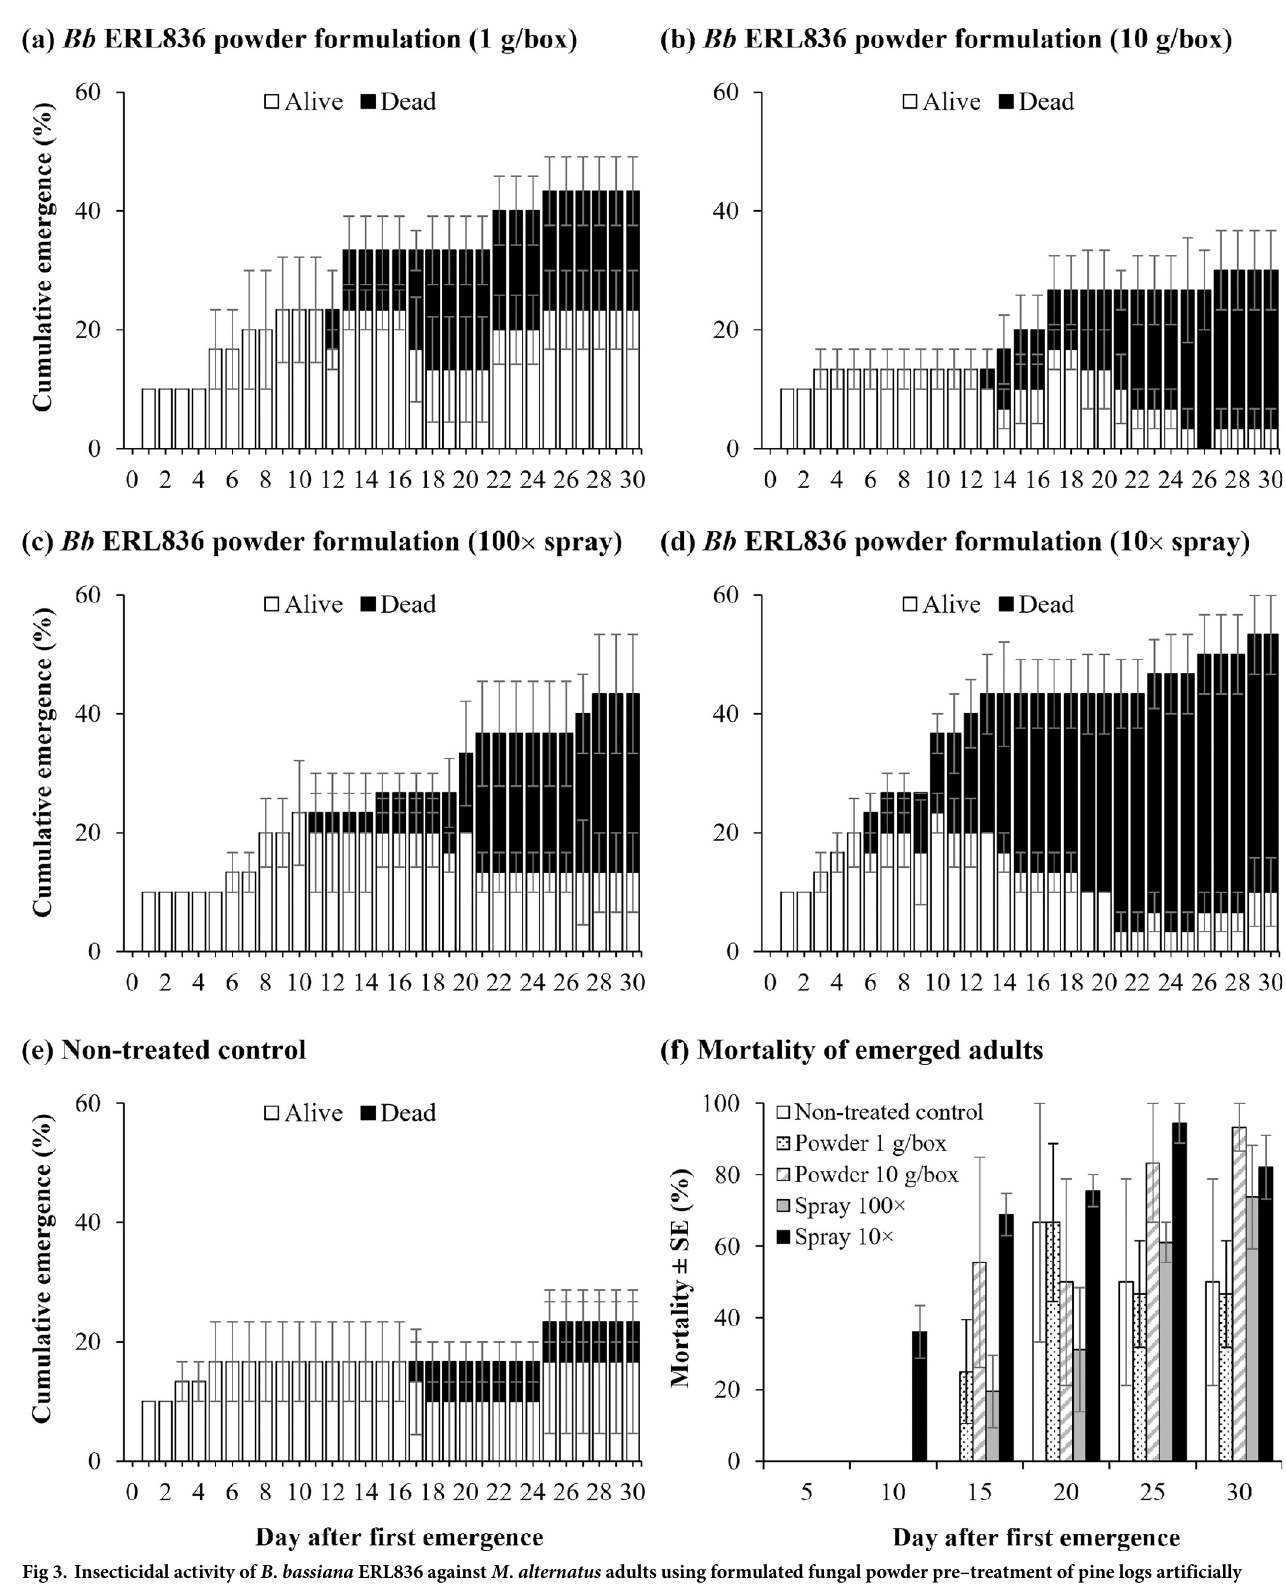
PLOS ONE | https://doi.org/10.1371/journal.pone.0274086 September 2,